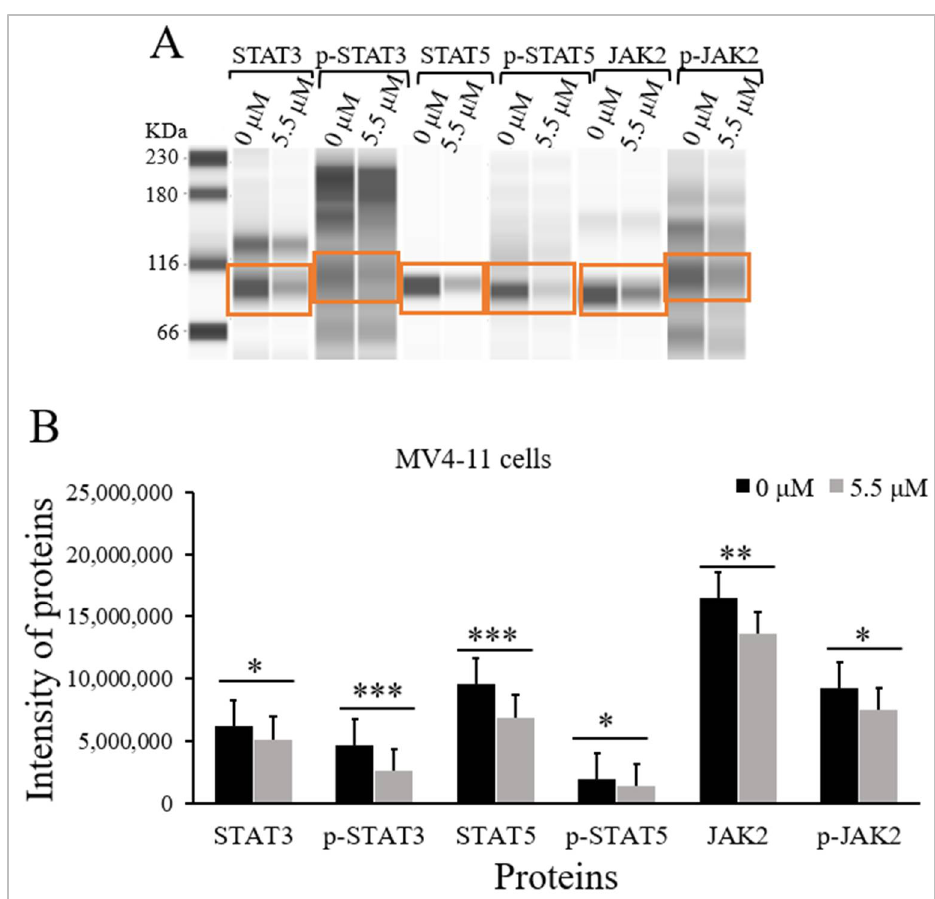
Figure 3. Effect of TQ on the activation status of JAK/STAT signaling in MV4-11 cells. The cells were incubated for 48 h with 5.5 μM TQ. The protein levels were determined by Jess simple western analysis. ( A ) Images of Jess simple western analysis for the target proteins before and after TQ treatment. ( B ) The bar graph demonstrates the reduction of STAT3, p-STAT3, STAT5, p-STAT5, JAK2, and p-JAK2 protein levels in MV4-11 cells after TQ treatment. Wilcoxon signed rank test was conducted, and the results are presented as medians and interquartile range (error bars) (n = 3), where * p < 0.05, ** p < 0.01, *** p < 0.001 are significant versus untreated control cells. Table 1. Medians of protein intensity in MV4-11 cells.